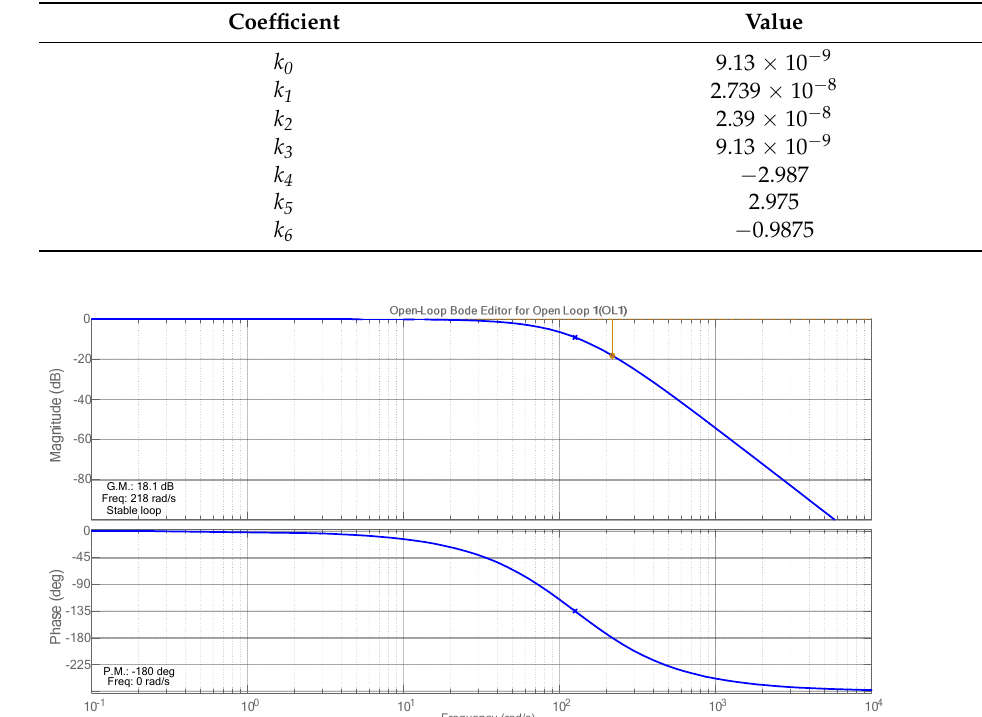
Figure 3. Low-pass filter frequency response.